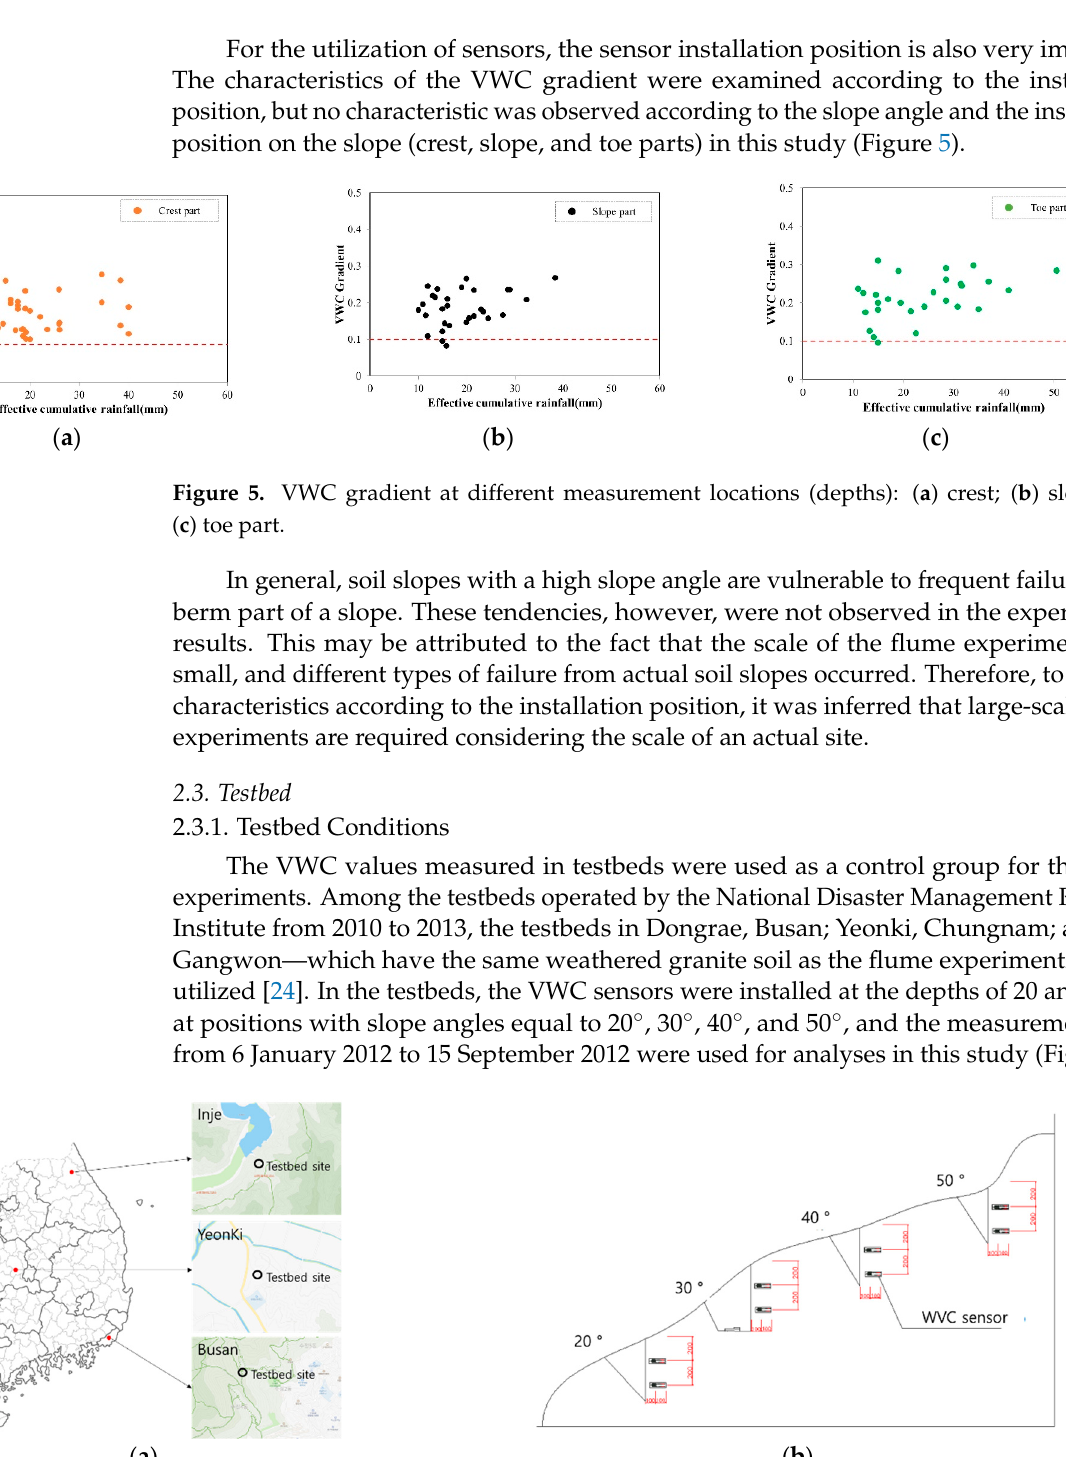
Figure 6. Testbed site: ( a ) location of testbed sites; ( b ) cross section of the installed sensor.